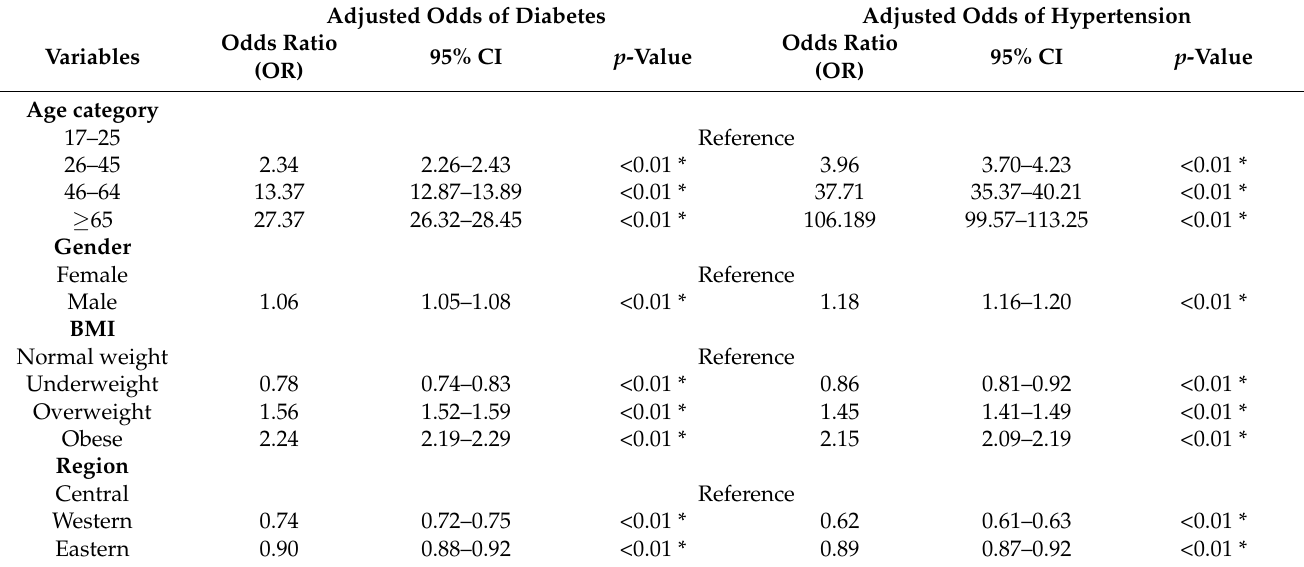
Figure 2. Prevalence of weight category by gender: Non-Saudis ( n = 42,394). An independent association was also observed between obesity and hypertension: obese patients were 2.1-fold more likely to have hypertension ( p -value <0.01). Gender was also a significant predictor of hypertension. Males were 18% more likely to be diagnosed with hypertension than females (OR = 1.18, 95% CI = 1.16, 1.20, p < 0.01). When comparing Saudi regions to the central region, western and eastern areas were associated with a reduced likelihood of hypertension (western: OR = 0.62, 95% CI = 0.61, 0.63, p < 0.01 and eastern: OR = 0.89, 95% CI = 0.87, 0.92, p < 0.01, Table 3). Table 3. Logistic regression of the association between BMI and the likelihood of diabetes and hypertension. Adjusted Odds of